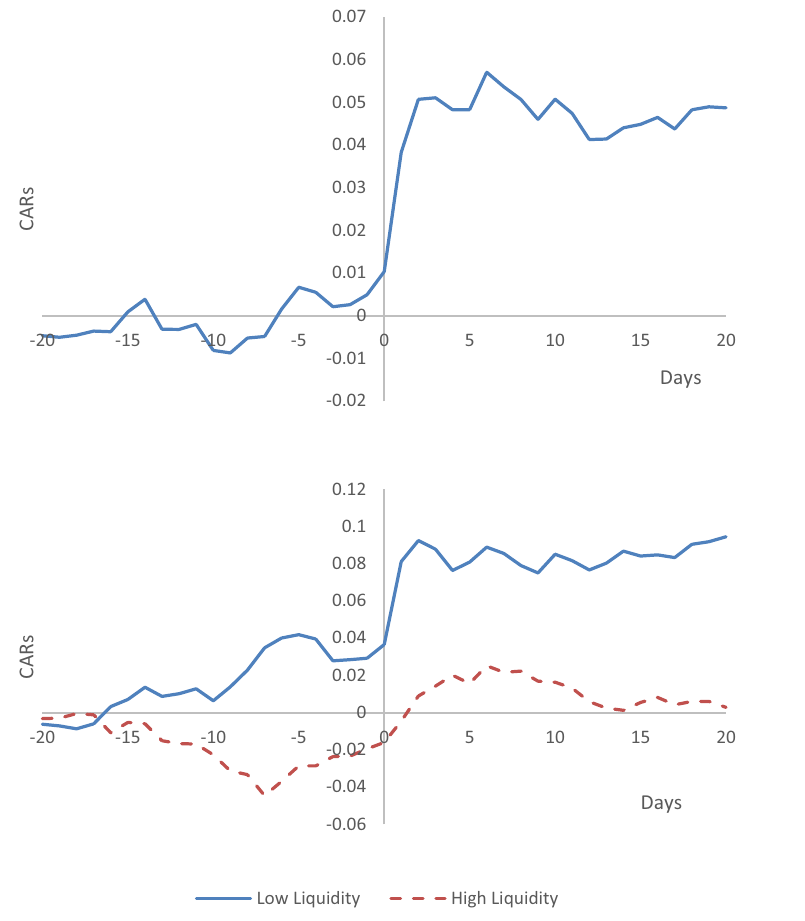
Figure 2. The market reaction around the switch announcement